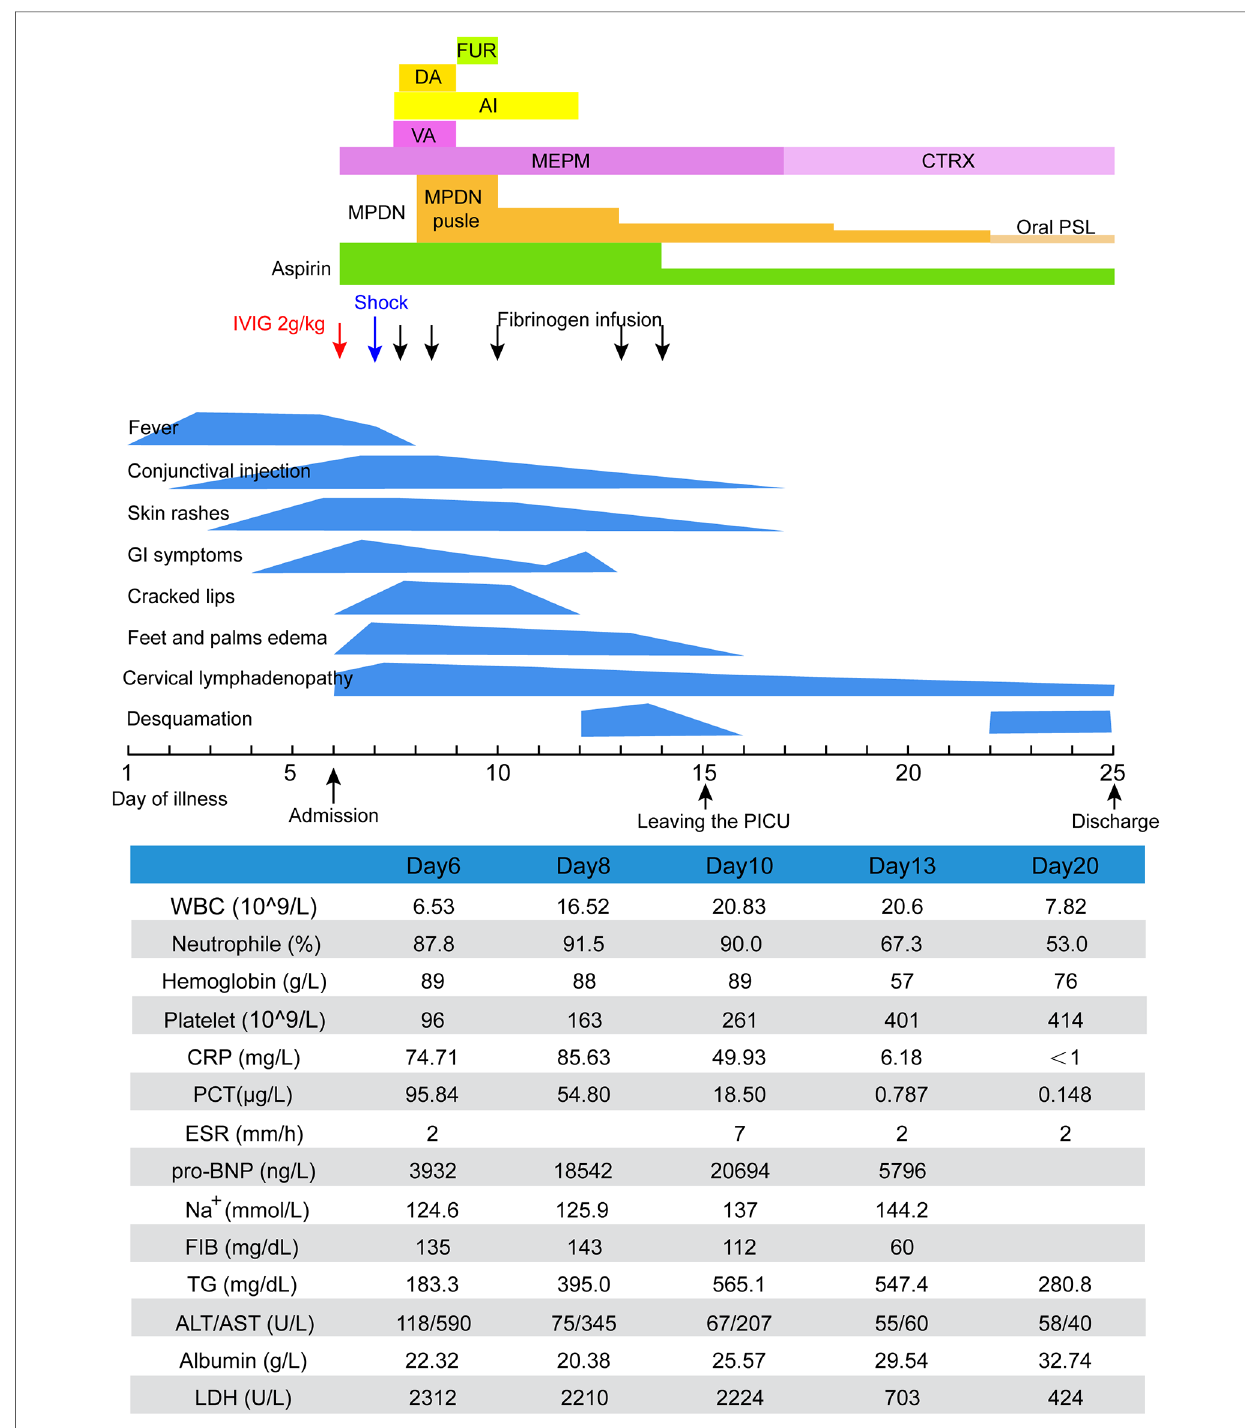
FIGURE 1 Clinical course of case 1. AI, albumin infusion; ALT, alanine transaminase; AST, aspartate aminotransferase; CRP, C-reactive protein; CTRX, ceftriaxone; DA, dopamine; ESR, erythrocyte sedimentation rate; FIB, fi brinogen; FUR, furosemide; IVIG, intravenous immunoglobulin; LDH, lactate dehydrogenase; MEPM, meropenem; MPDN, methylprednisolone; PCT, procalcitonin; pro-BNP, pro-brain natriuretic peptide; PSL, prednisolone; TG, triglycerides; VA, vancomycin; WBC, white blood